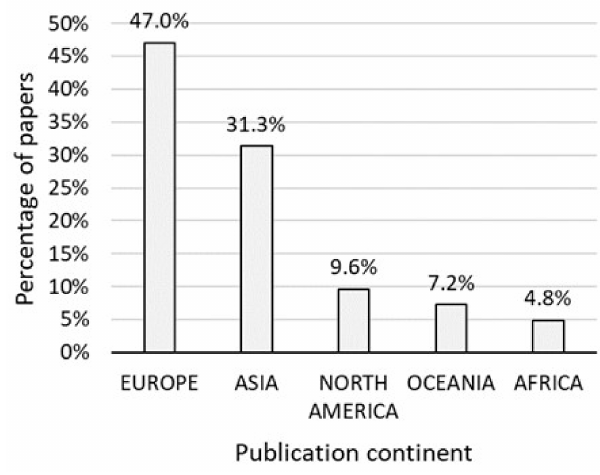
Figure A3. Percentage of papers produced in each continent.